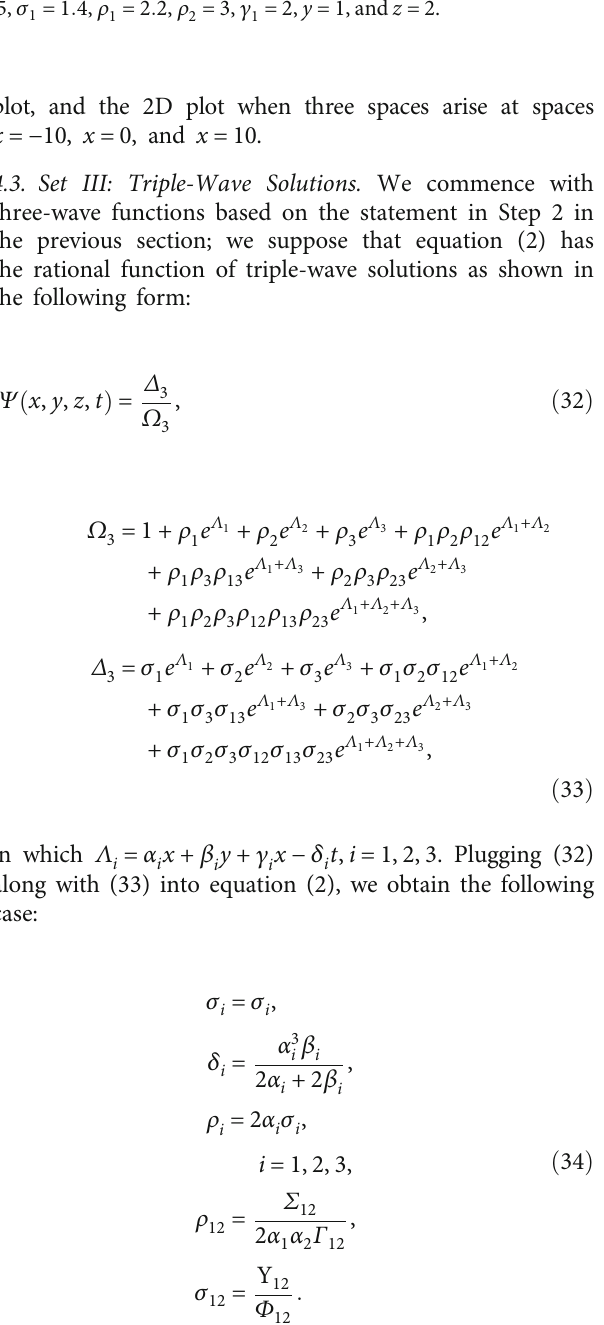
= 1, β = 1 : 5, σ = 1 : 4, ρ = 2 : 2, ρ = 3, γ = 2, y = 1, and z = 2 . 1 1 1 1 2 1